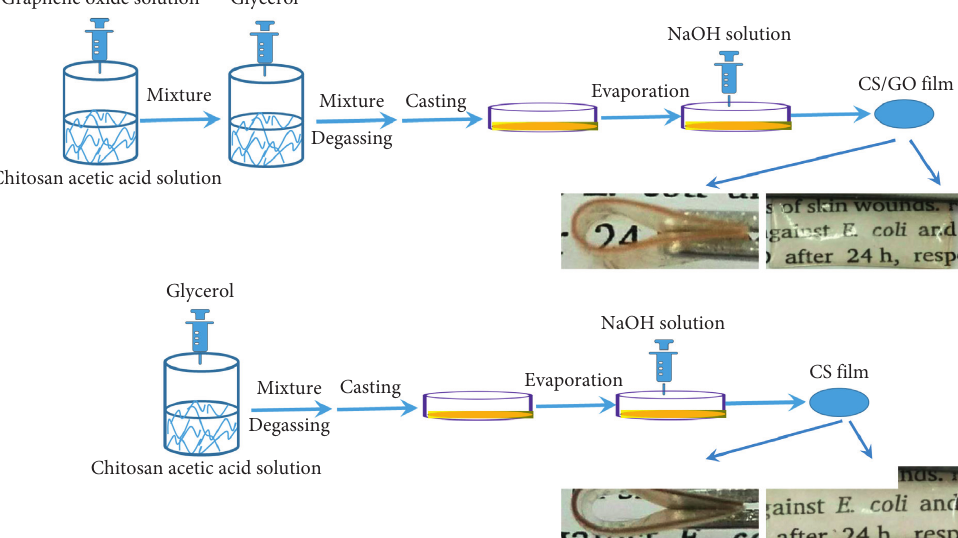
Figure 1: Schematic illustration to show films preparation and their digital photos to show the transparency and toughness.